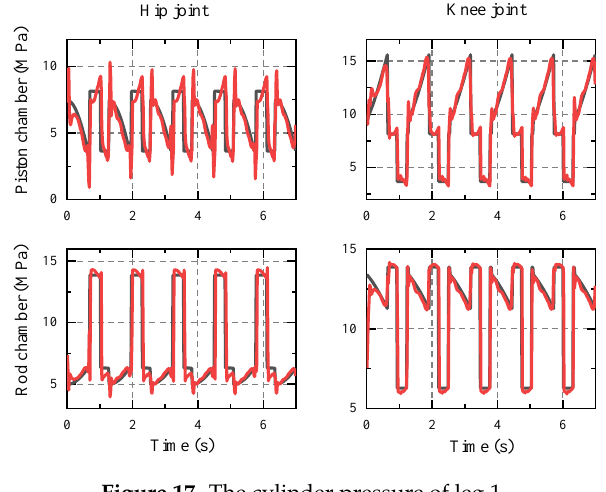
Figure 17. The cylinder pressure of leg 1.